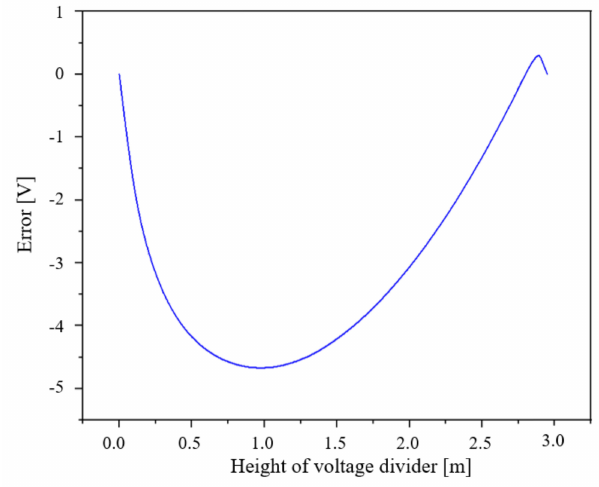
Figure 9. Potential error of the voltage divider at steady state.